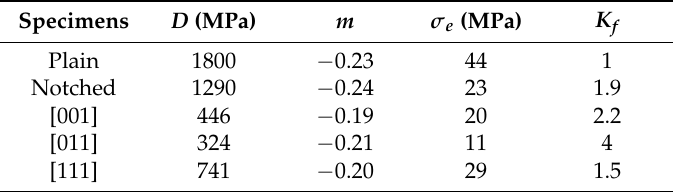
Table 4. Basquin law parameters D and m , endurance limits, and fatigue stress concentration factors.